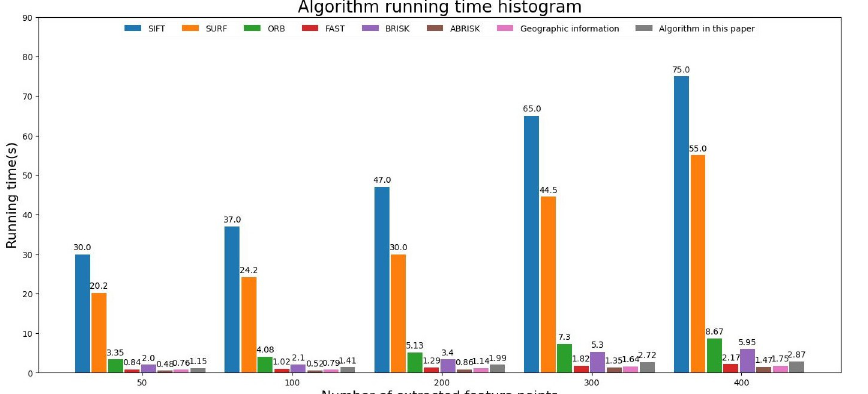
Fig 9. Histogram of algorithm run time